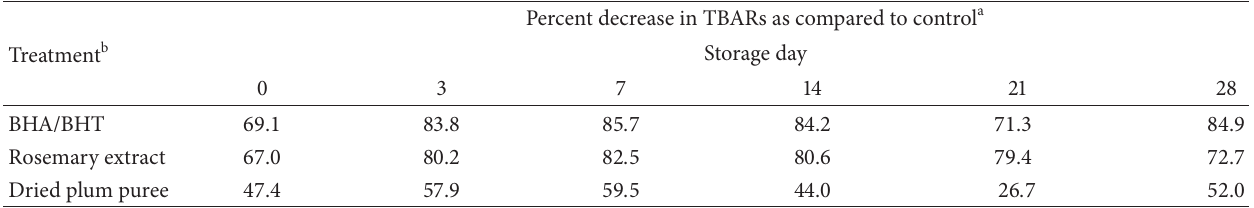
a Data not statistically analyzed, but percentages were computed from the statistical data in Table 3. b BHA/BHT = butylated hydroxyanisole/butylated hydroxytoluene (0.02 % of fat content); dried plum puree = 3.0 % based on batch weight; rosemary extract = 0.25 % based on batch